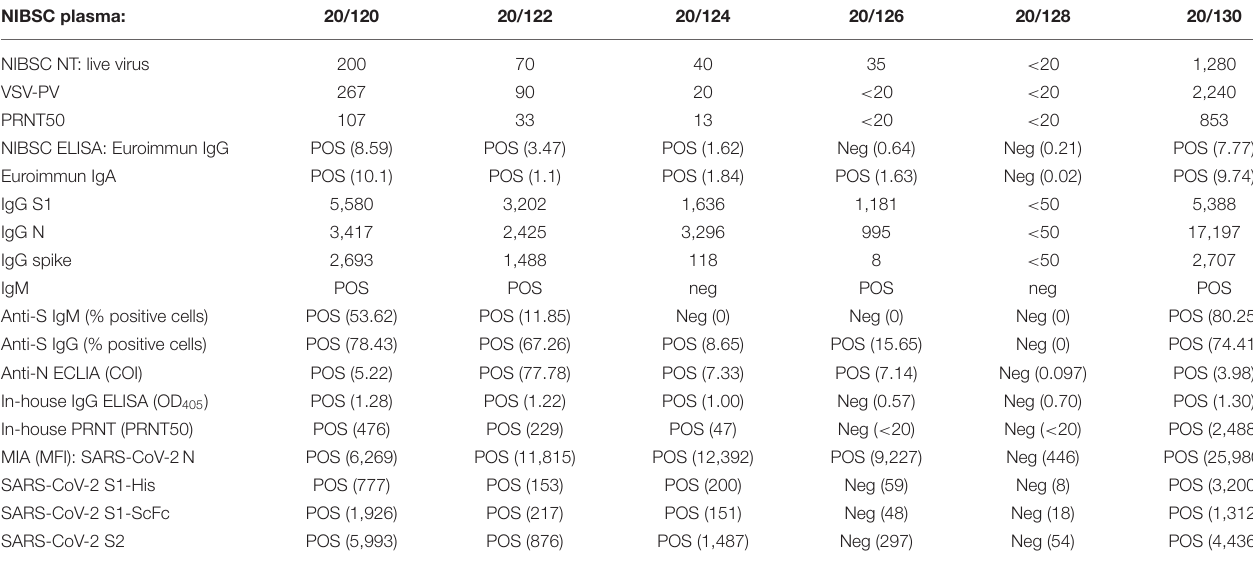
TABLE 1 | Results for the NIBSC reference samples.